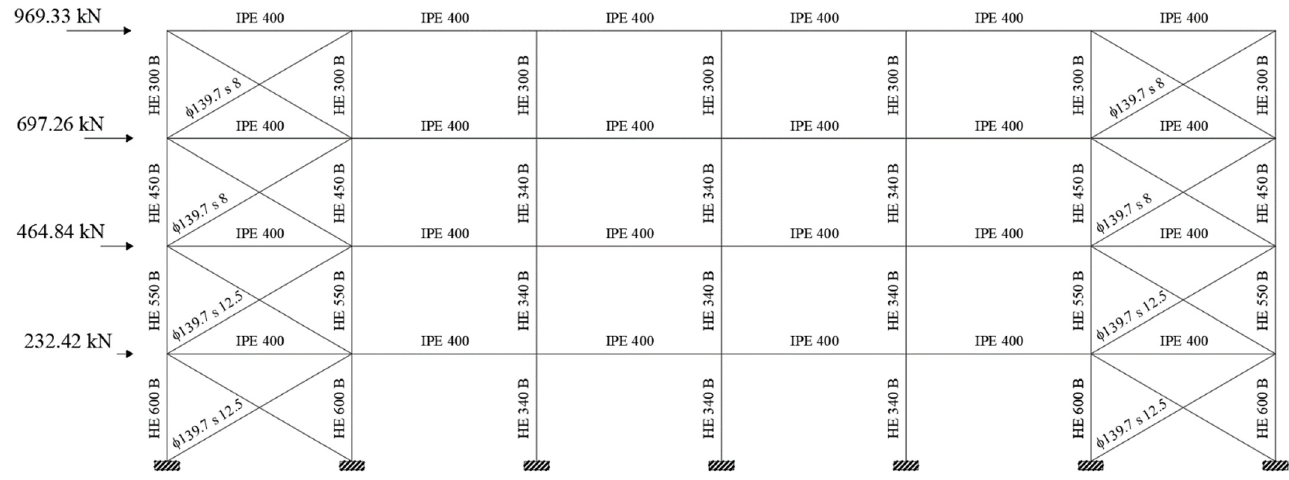
Figure 5. Diagram of the frame with indication of beams, diagonals, columns, and seismic forces (GCBF).